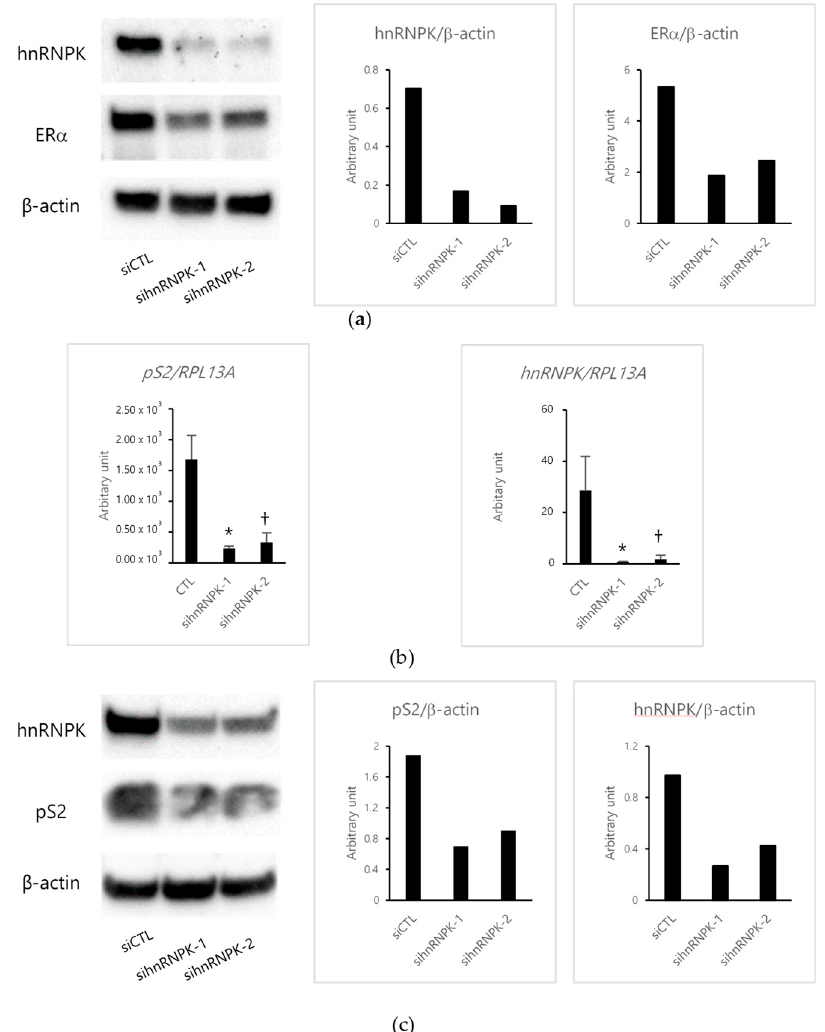
Figure 2. The effects of estradiol (E2) in hnRNPK-knockdown MCF-7 cells. ( a ) Western blotting assay of hnRNPK (65 kDa) and estrogen receptor (ER) α (66 kDa) in MCF-7 cells transfected with hnRNPK-specific small interfering RNAs (siRNAs) (sihnRNPK-1 and sihnRNPK-2) or negative control siRNA (siCTL) for 72 h. β -actin was the loading control. ( b ) Real-time PCR analysis of pS2 and hnRNPK in MCF-7 cells transfected with sihnRNPK-1 and sihnRNPK-2 or siCTL and then treated with E2 for 24 h. Left panel, * p = 0.0007 versus siCTL for sihnRNPK-1; † p = 0.0010 versus siCTL for sihnRNPK-2. Right panel, * p = 0.0080 versus siCTL for sihnRNPK-1; † p = 0.0094 versus siCTL for sihnRNPK-2. ( c ) Western blotting assay of pS2 (13 kDa) and hnRNPK (65 kDa) in MCF-7 cells transfected with sihnRNPK-1 and sihnRNPK-2 or siCTL and then treated with E2 for 48 h. β -actin was the loading control. The full-length Western blot images are illustrated in Figure